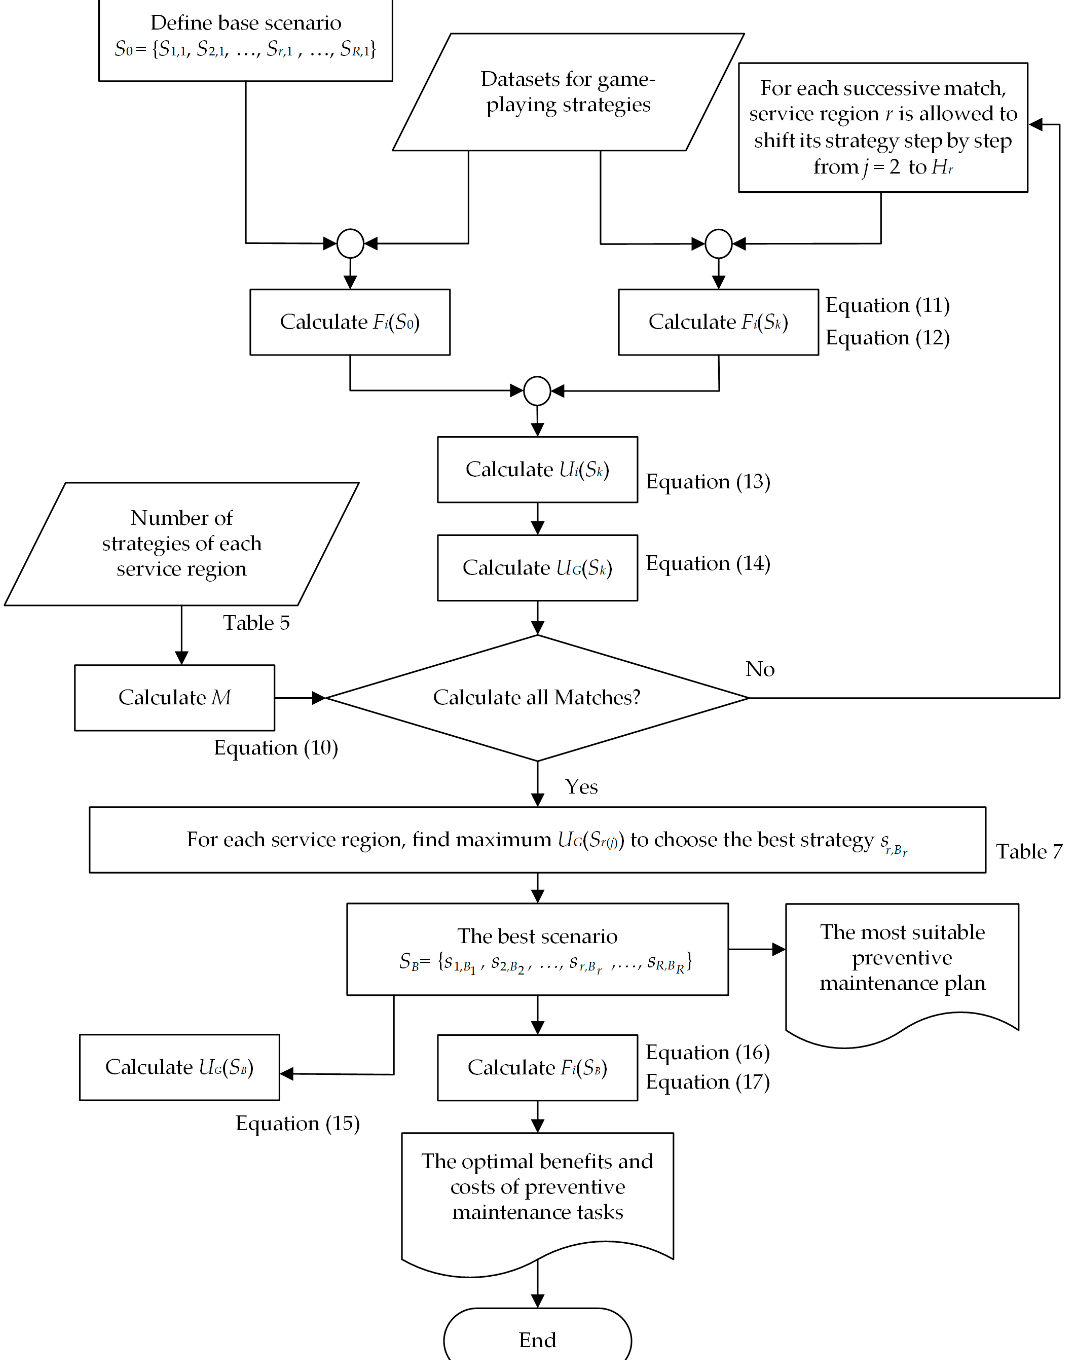
Figure 5. Optimal preventive maintenance planning using cooperative game theory.